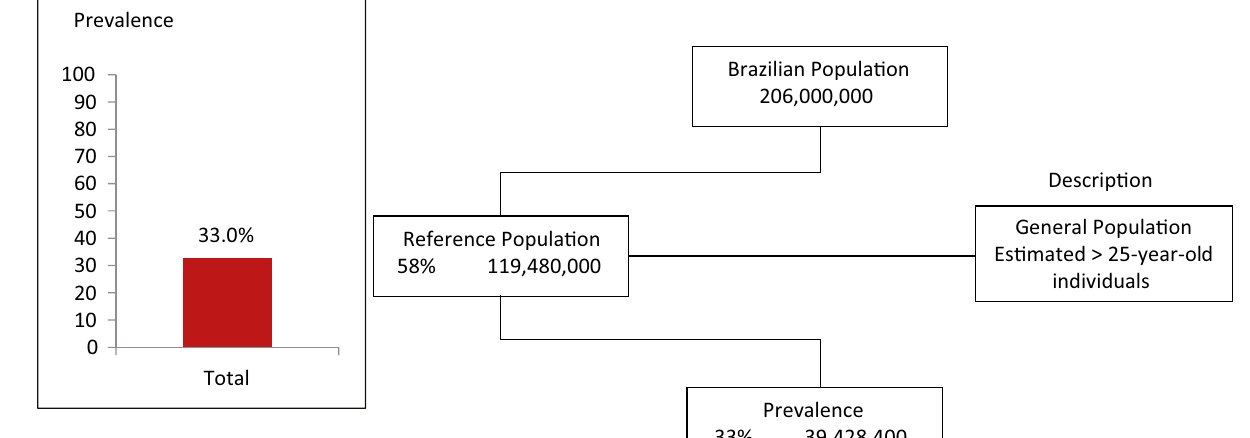
Figure 1 - Prevalence of osteoarthritis in